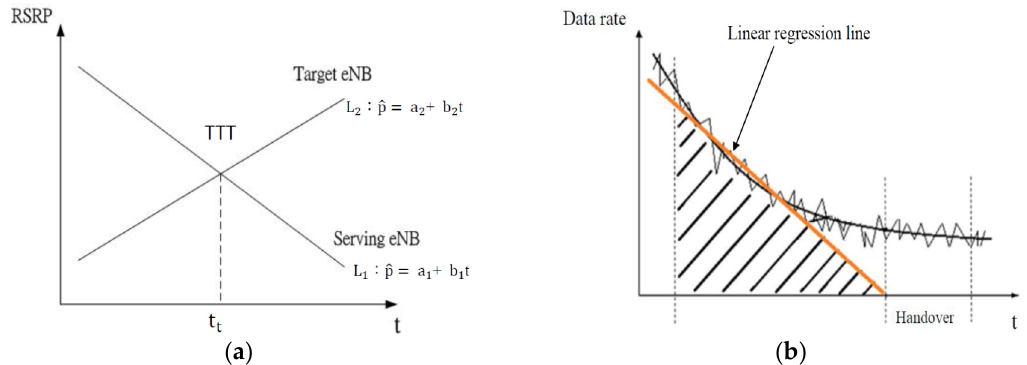
Figure 2. Prediction for ( a ) time-to-trigger (TTT) of handover and ( b ) amount of data transmitted before handover.